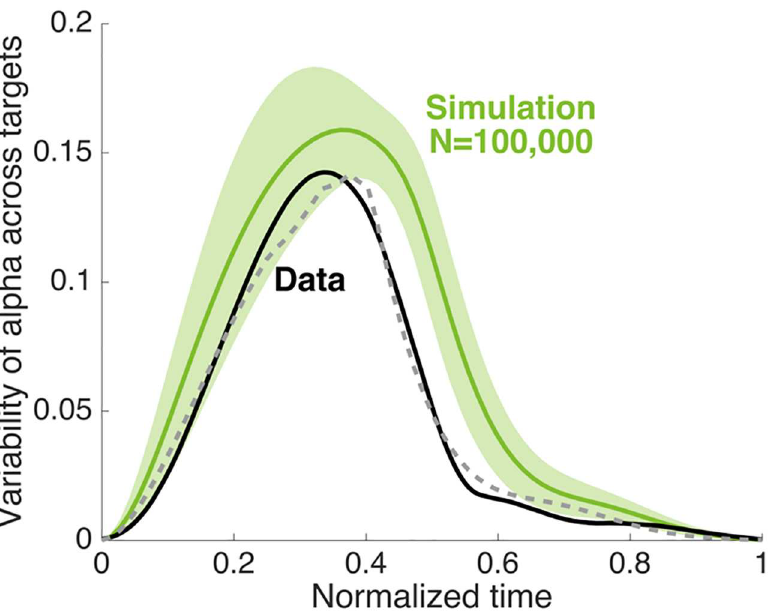
Fig 10. Parametric sensitivity of the model. Temporal profile of the variabilityof the alpha level in Experiment 1. Data (black) is mean across subjects (same as Fig 4D). For the simulation(green) we performed 10 5 simulations with different parameter settings in the model and for each simulationwe calculatedthe variability across the 12 directionsfor each time point and plot the mean ± s.d. of these variabilities. The grey dashedline is the singlesimulationwhich is closest to the data